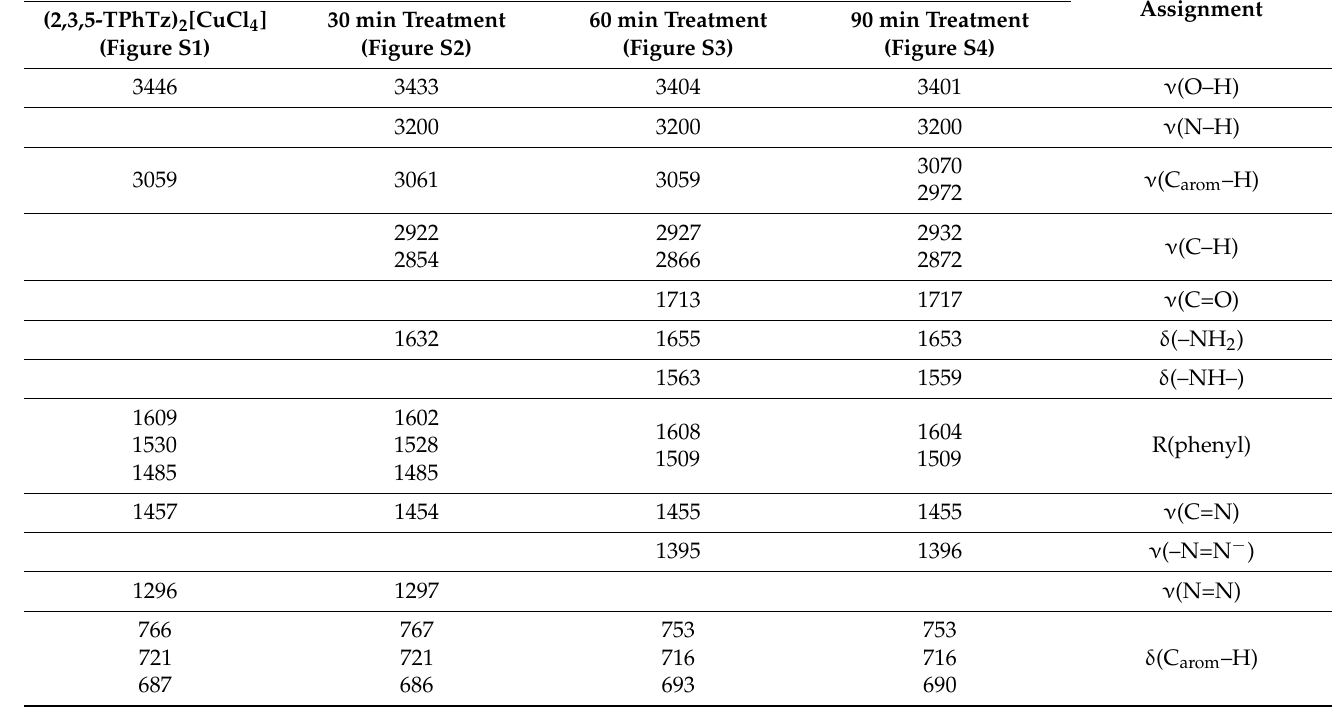
Table 1. The main vibrational frequencies (cm − 1 ) in the infrared spectra of the pure complex and PCM destruction products in supercritical ethanol in the presence of the (2,3,5-TPhTz) 2 [CuCl 4 ], depending on the duration of